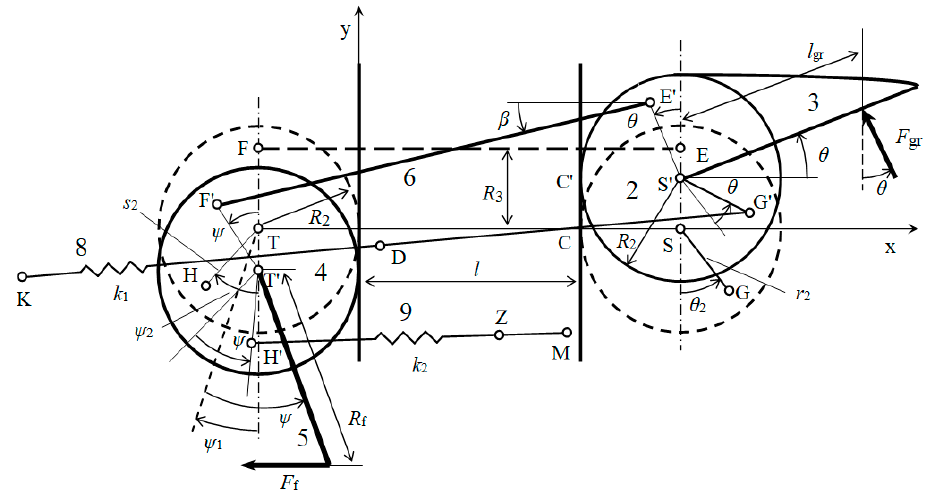
Figure 3. Kinematical scheme of the laparoscopic grasper mechanism.